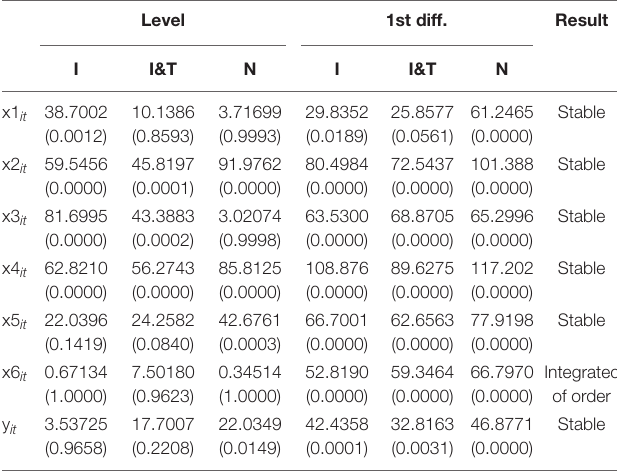
TABLE 3 | ADF statistics and P-value results of unit root test of panel